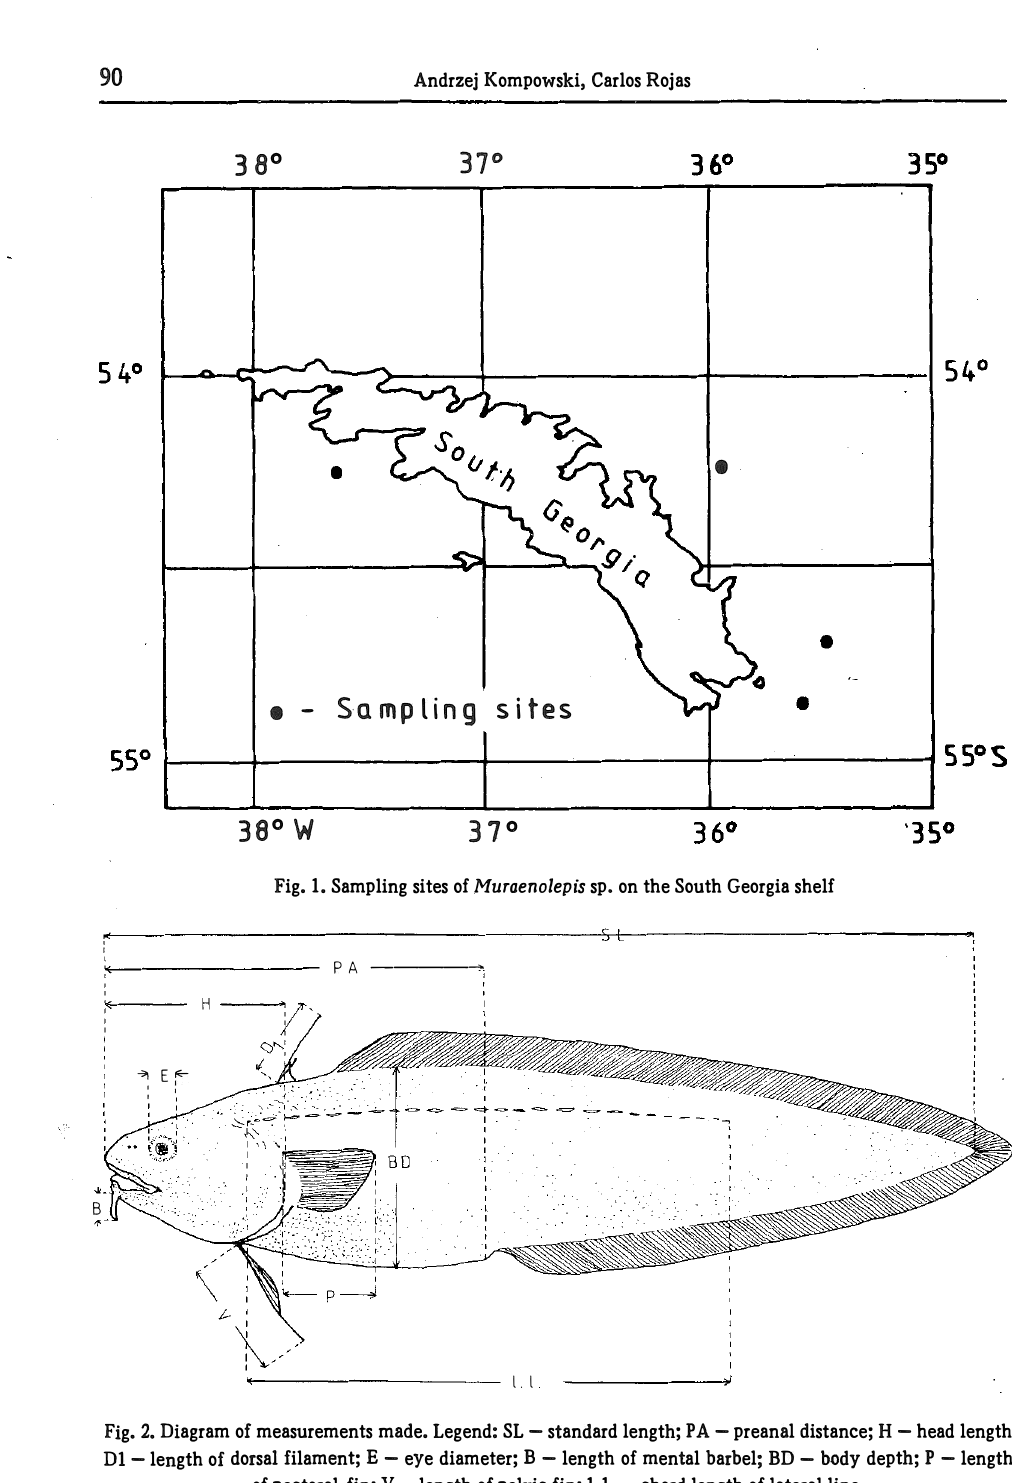
l. l Fig. 2. Diagram of measurements made. Legend: SL -standard length; PA - preanal distance; H -head length; Dl -length of dorsal filament; E -eye diameter; B -length of mental barbel; BD -body depth; P -length of pectoral fin; V -length of pelvic fin; 1.1. -chord length of lateral